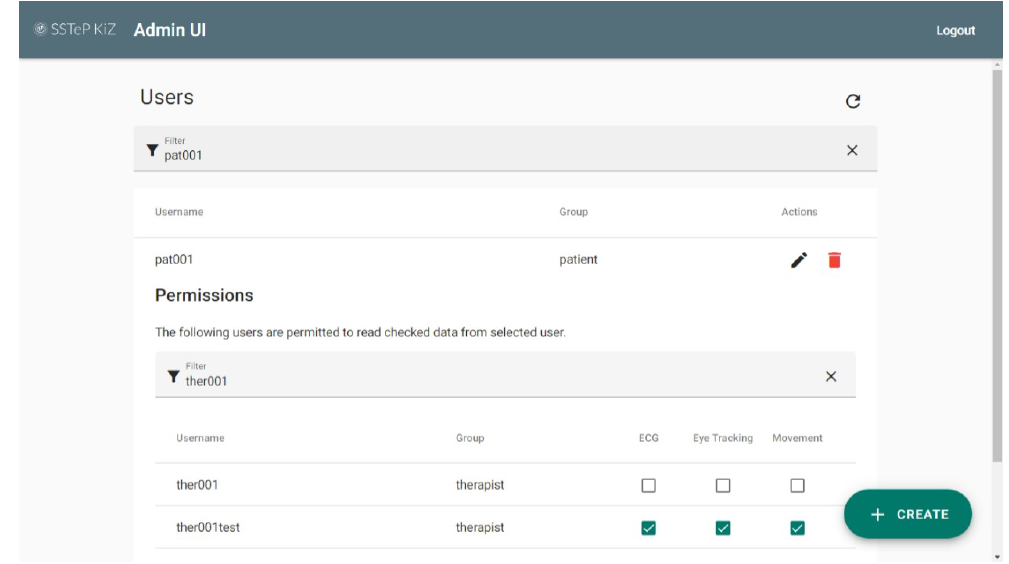
Figure 21. Screenshot of the Administration Portal.